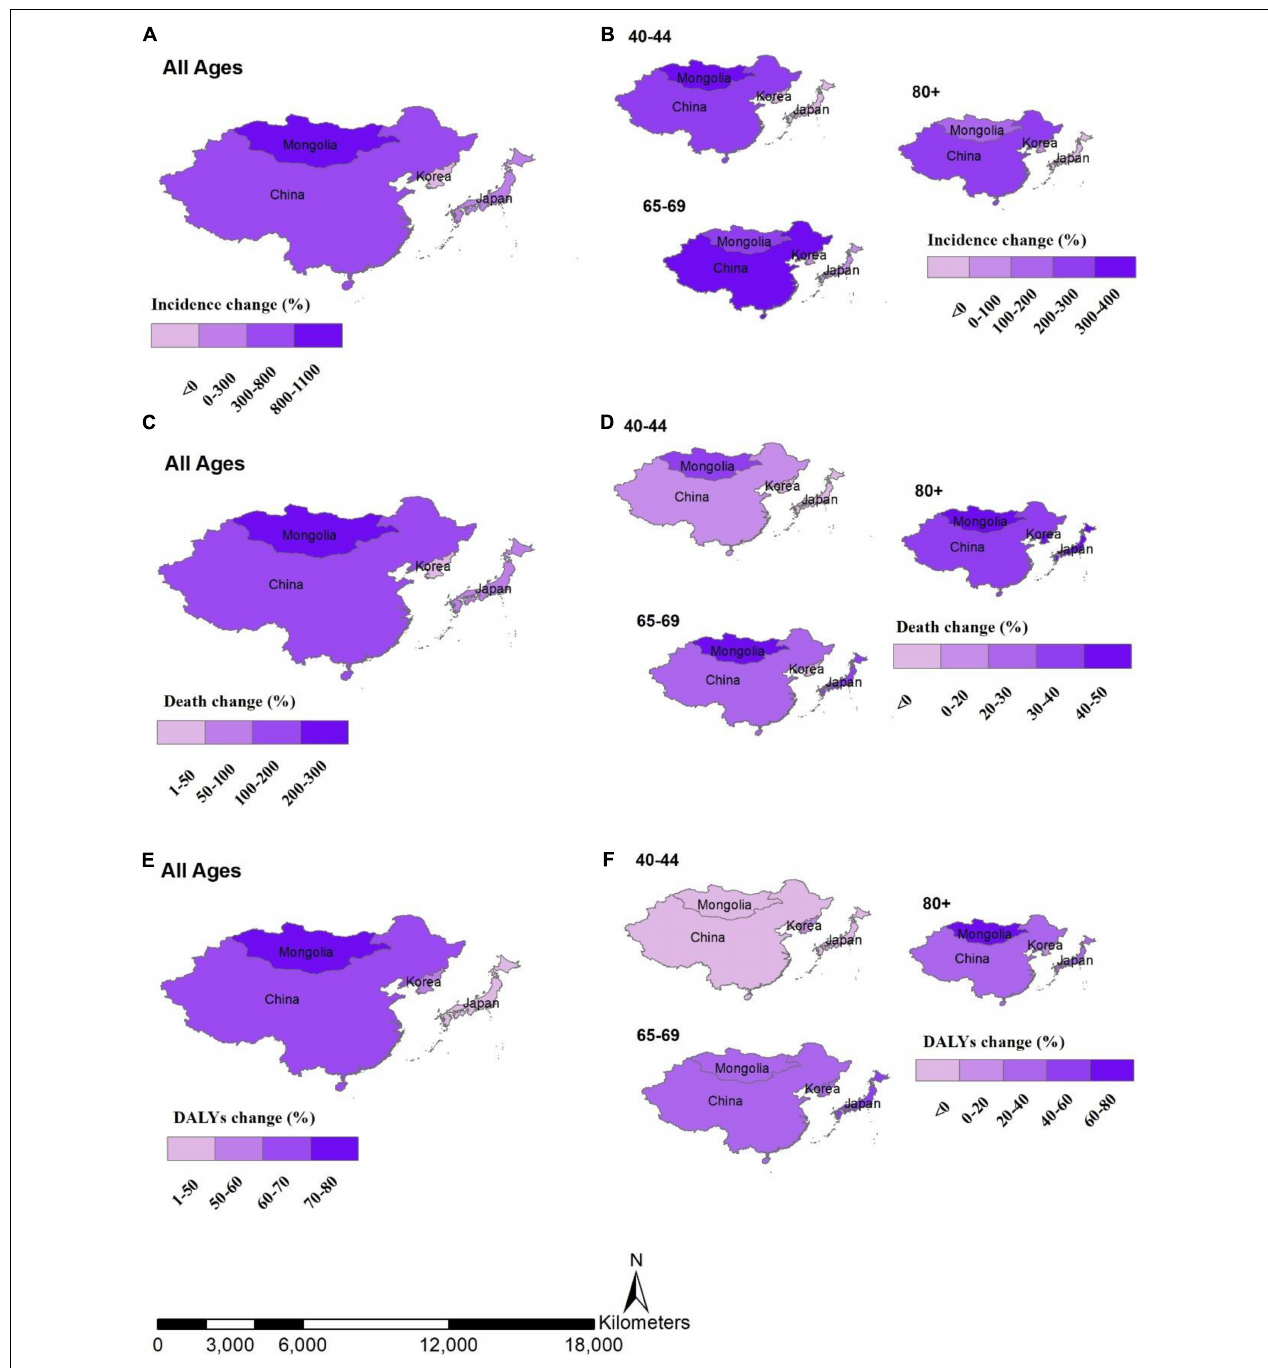
FIGURE 2 | Percent change between 1990 and 2019, by location and age group, (A) incidence change in all ages by location, (B) incidence change by age groups, (C) death change in all ages by location, (D) death change by age groups, (E) DALYs change in all ages by location, (F) DALYs change by age groups.